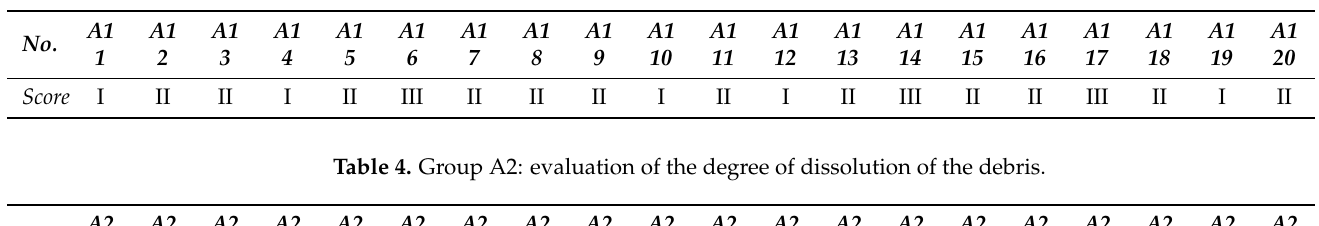
Table 3. Group A1: evaluation of the degree of dissolution of the debris.